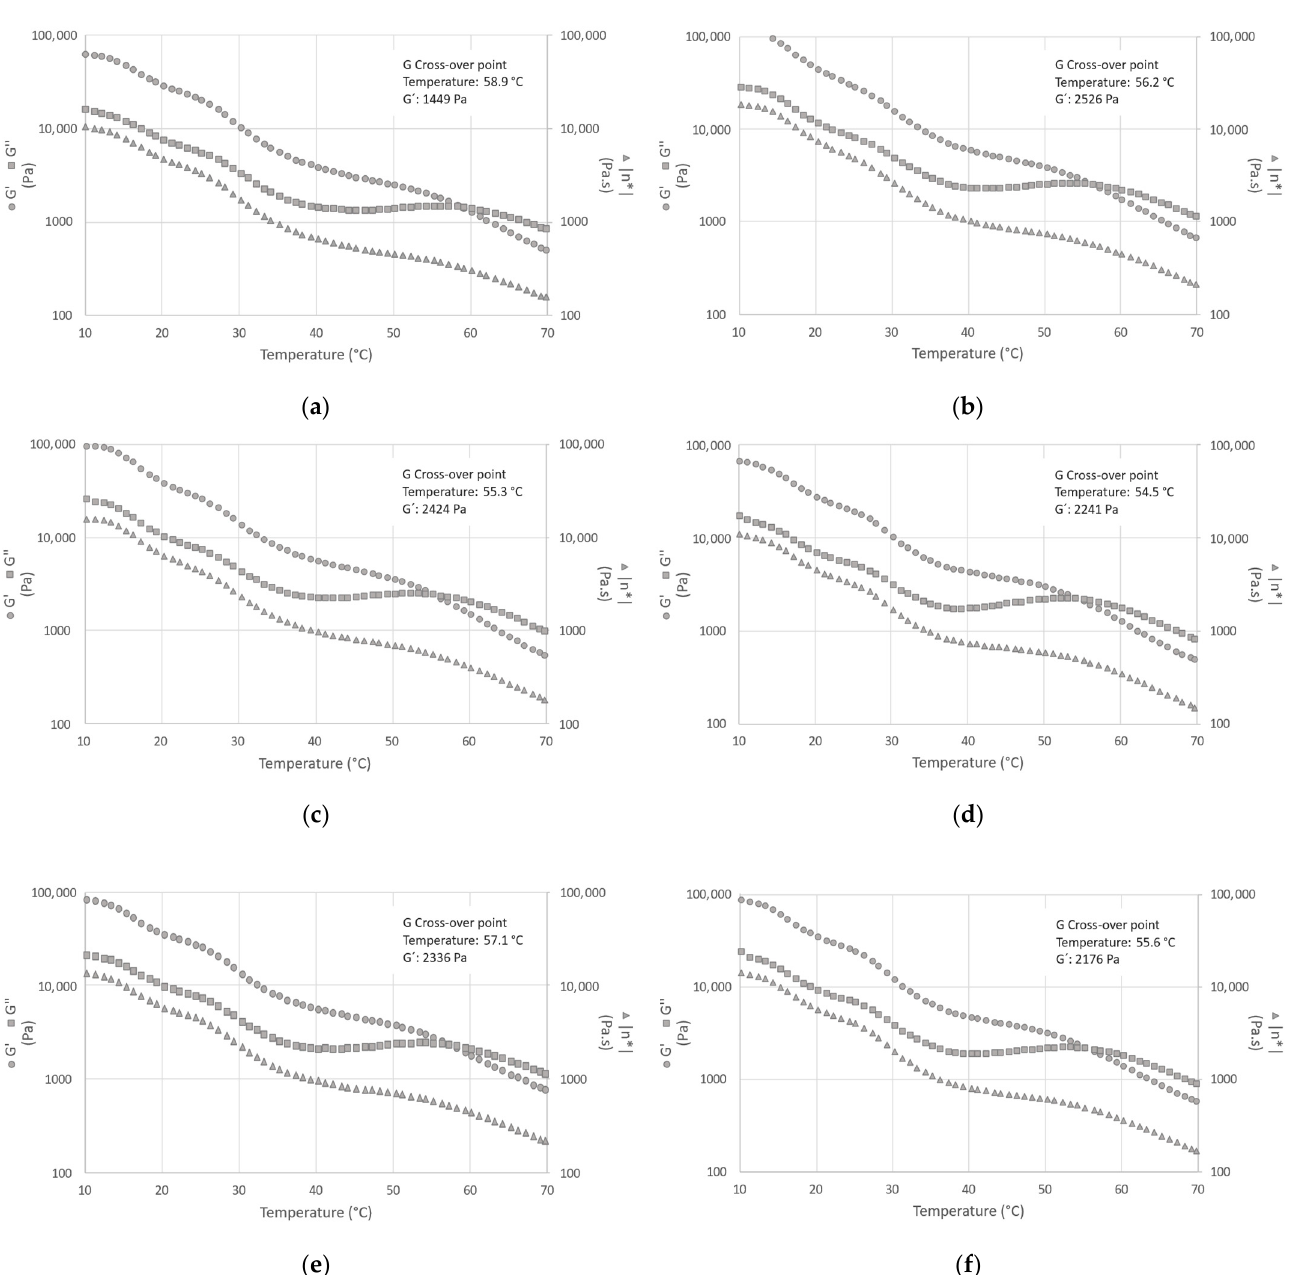
Figure 5. Influence of temperature on viscosity of cheese produced with milk treated with sonication at ( a ) 25 kHz for 0 min; ( b ) 45 kHz for 0 min; ( c) 25 kHz for 15 min; ( d ) 45 kHz for 15 min; ( e ) 25 kHz for 30 min; and ( f ) 45 kHz for 30 min.